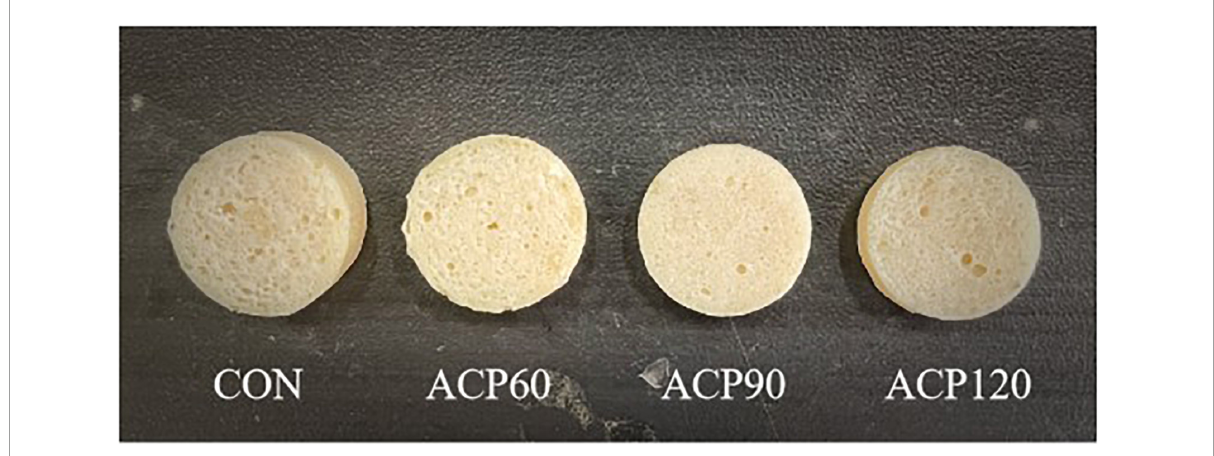
FIGURE2 Appearance of surimi gels at different treatment times with ACP. (CON, surimi gels without ACP treatment; ACP60, surimi gels treated with ACP for 60 s; ACP90, surimi gels treated with ACP for 90 s; ACP120, surimi gels treated with ACP for 120 s).